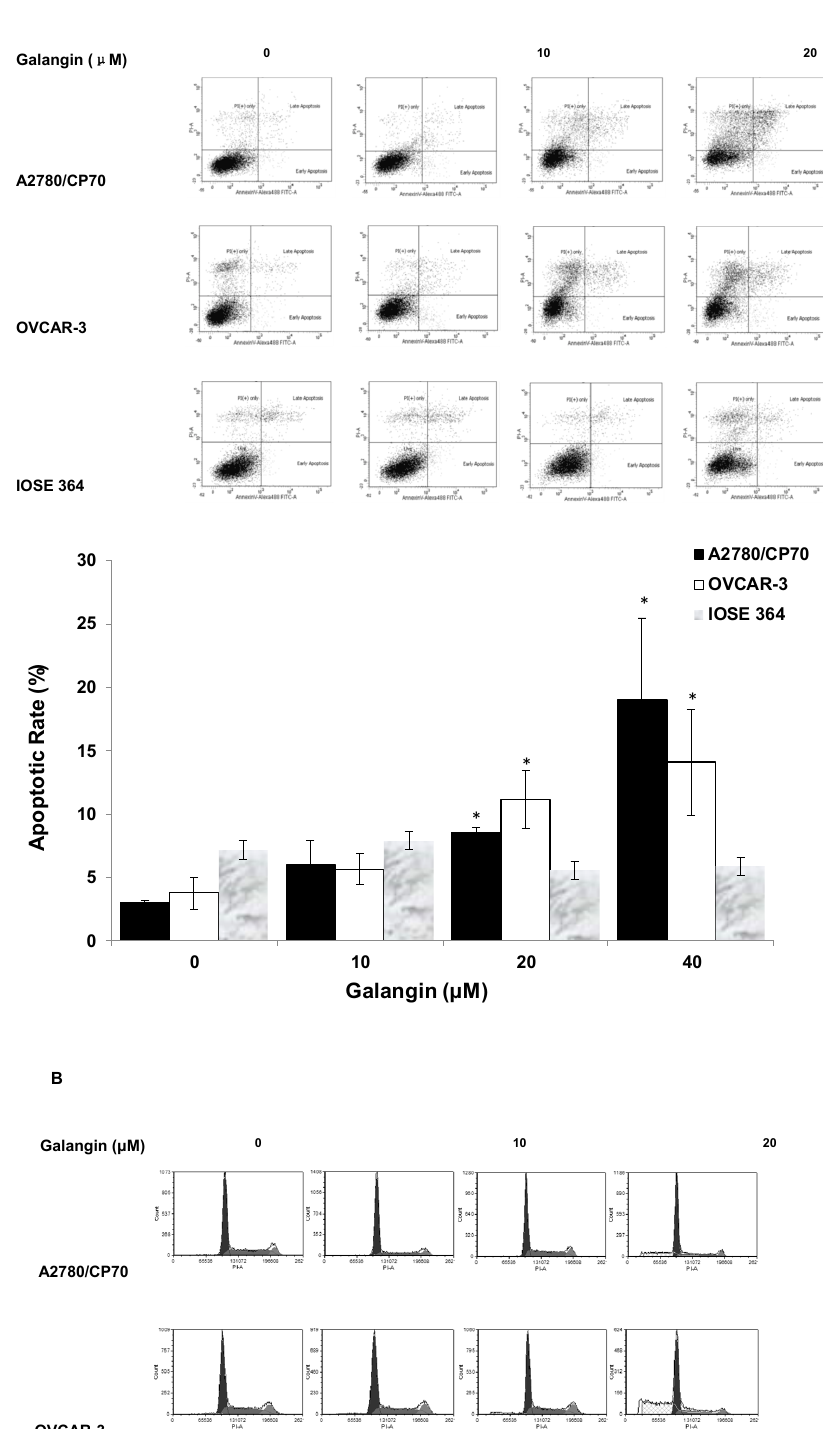
Figure 4. E ff ect of galangin on apoptosis and the cell cycle in ovarian cancer cells A2780 / CP70 and OVCAR-3. ( A ) A2780 / CP70, OVCAR-3 and IOSE 364 cells were treated with galangin at di ff erent concentrations for 24 h, and the apoptotic rates were measured by flow cytometry. * p < 0.05 as compared to the control. ( B ) A2780 / CP70 and OVCAR-3 treated with galangin at di ff erent concentrations for 24 h are analyzed by flow cytometry after PI